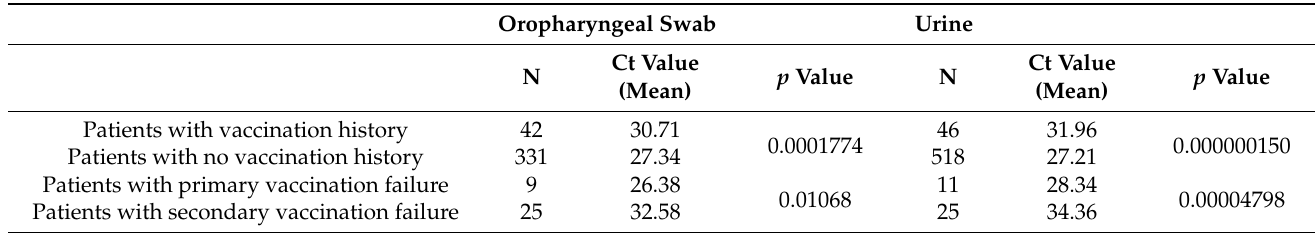
Table 3. Mean cut-off point of cycle threshold (Ct) value comparison between vaccinated and unvaccinated cases and patients with primary or secondary vaccination